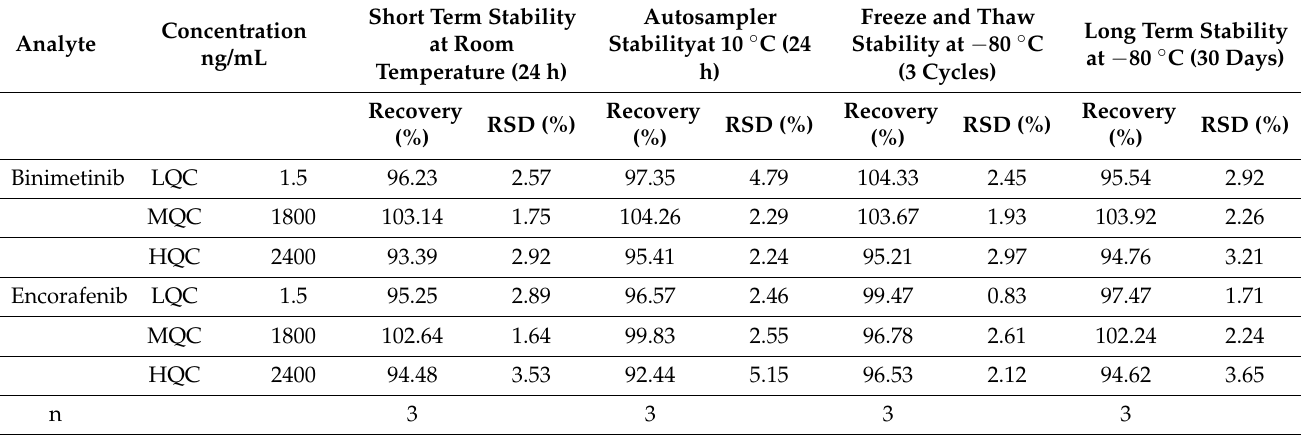
Table 6. Stability results for binimetinib and encorafenib in plasma at different